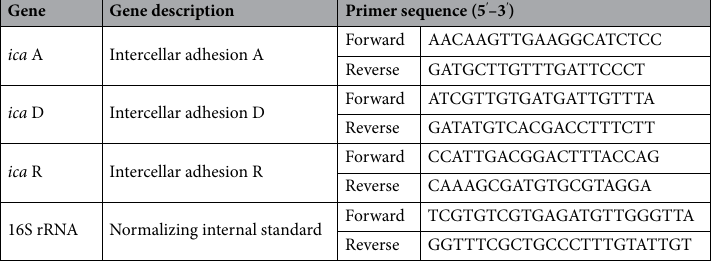
Table 2. Primers used in this